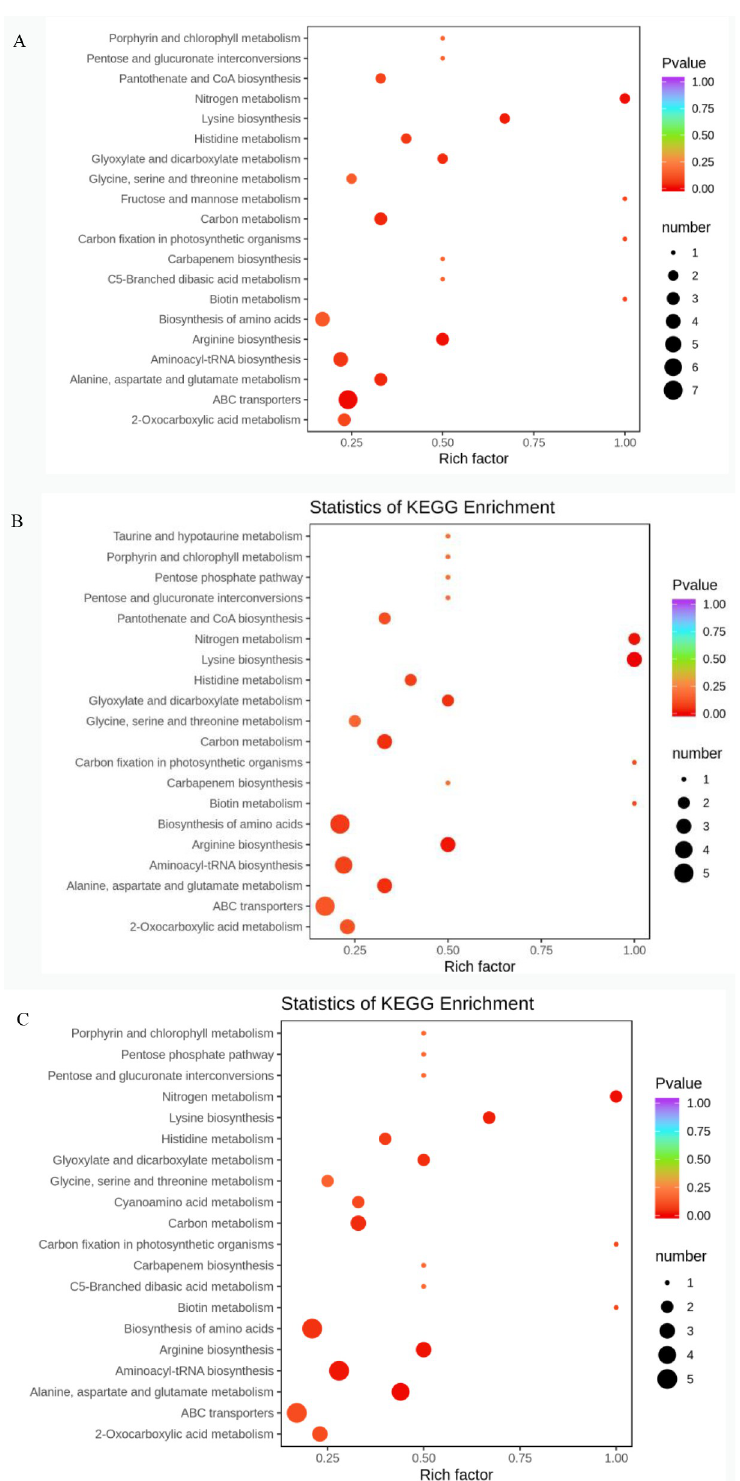
Fig 9. Enrichment analysis of KEGG metabolic pathway of differential metabolites in Z_VS_ C group. Note: A: KEGG differential enrichment bubble chart in ZA_VS_CK; B: KEGG differential enrichment bubble chart in ZB_VS_CK; C: KEGG differential enrichment bubble chart in ZC_VS_CK.